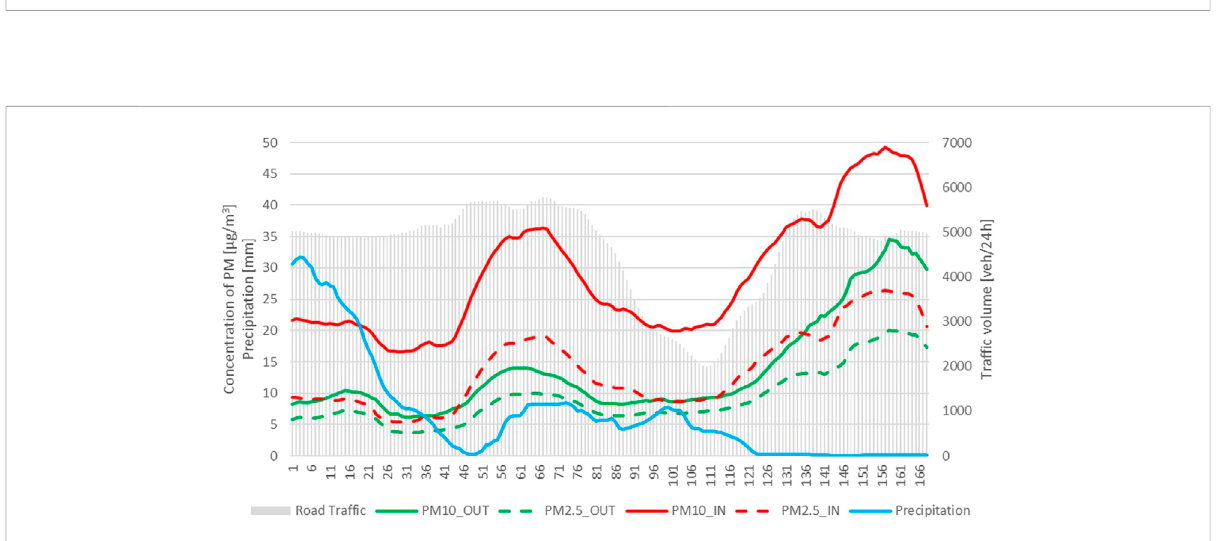
FIGURE 3 TrendofPMconcentrations, traf fi cvolume, and totalprecipitationduring measurementsinthePova ž ský Chlmec tunnel